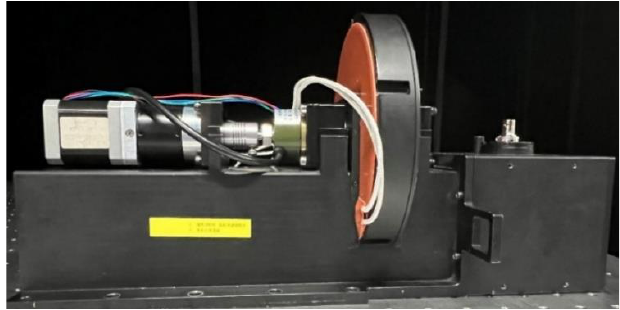
Figure 4. Picture of the transfer